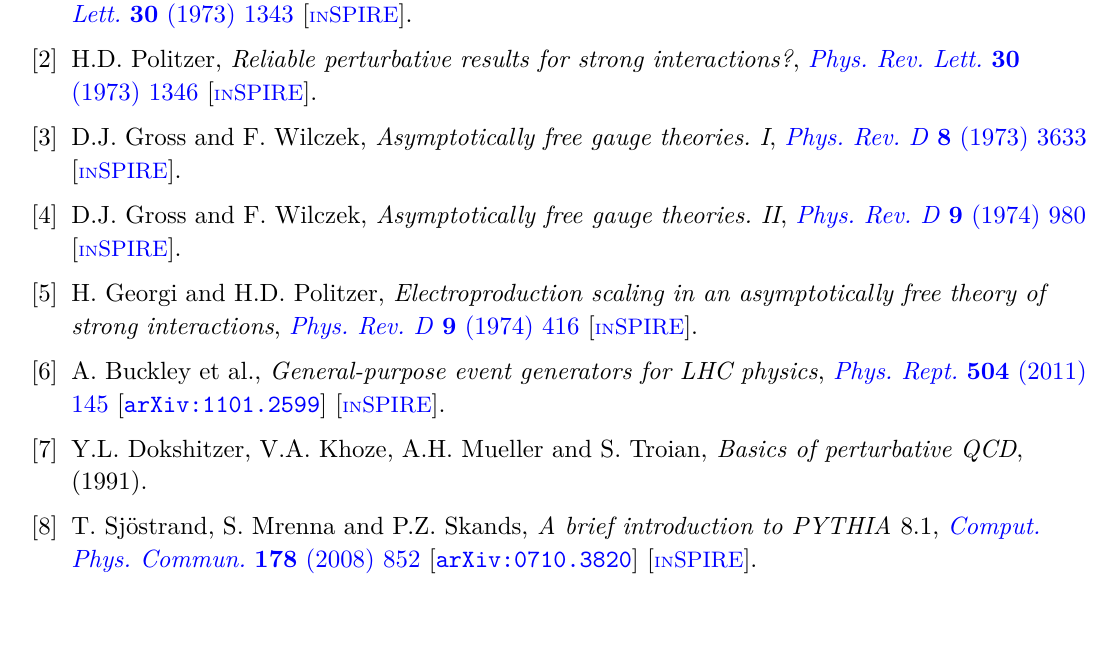
Figure 11. The j T distribution in p-Pb collisions at comparing to theoretical models in pp and p-Pb